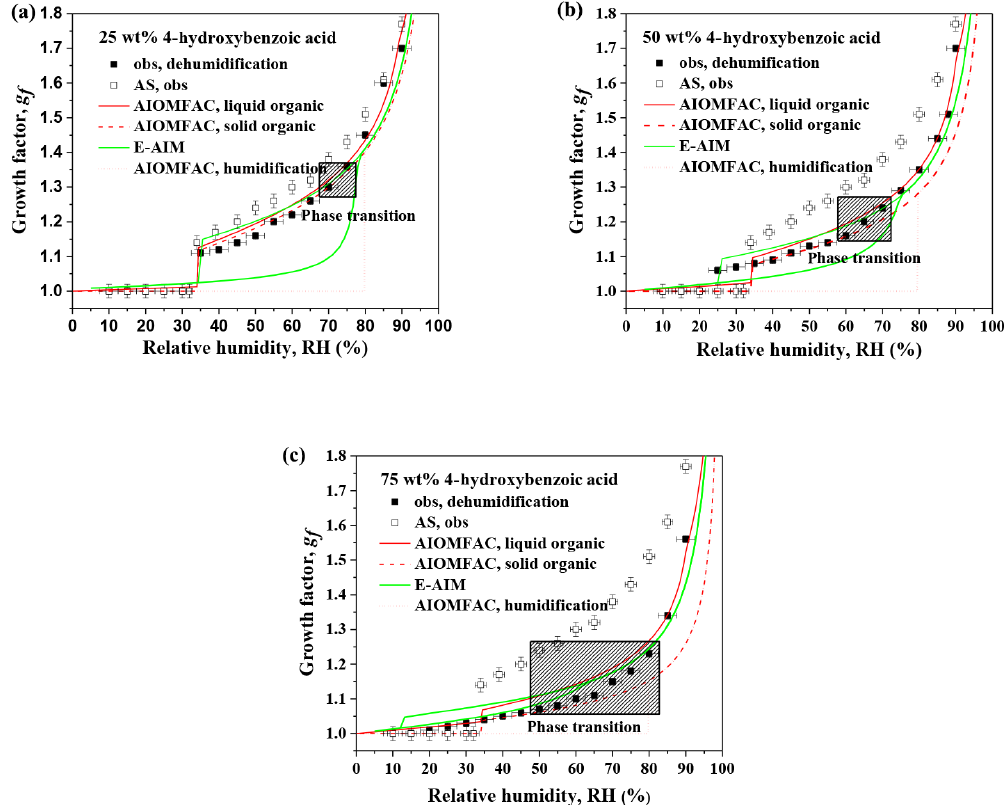
Figure 4. Hygroscopic growth factors, efflorescence of behavior, and model predications for dehydration experiments in the range from 90 to 5%RH at 298.15K (a, b, c) . Hygroscopic growth curves of mixtures consisting of 4-hydroxybenzoic acid and ammonium sulfate (solid symbols) at three different dry-state mass fractions (initial dry diameter of 100nm at RH < 5%) as compared to those of pure ammonium sulfate (open symbols). AIOMFAC-based model predictions for bulk systems are shown in red; E-AIM-predictions are shown in green for the case assuming that 4-hydroxybenzoic acid remains in the liquid state. Shaded rectangle: RH range of gradual crystallization of 4-hydroxybenzoic